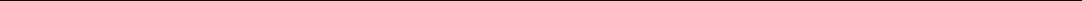
Fig. 5 Analysis of Whi7 function in transcription at Start. a Cultures of cdc15 SIC1-myc whi7 (JCY1843) transformed with the pWHI7 or pWHI7-NP centromeric plasmid were arrested in telophase by incubation for 3 h at 37 °C ( > 95% of cells arrested). After the release from the arrest, Whi7 binding to CLN2 and RNR1 promoter was investigated by ChIP assays. Western blot shows Whi7, Sic1, and Cdc28 (as loading control). Cell cycle progression was monitored by the oscillations of Sic1 and bud emergence that indicated execution of Start at 60 min. b Cultures of GAL1:CLN3 cln1 cln2 WHI7-GFP (JCY2008) were arrested in G1 by incubation for 3 h in YPD medium. Then, cells were transferred to YPGal medium and Whi7 binding to CLN2 promoter was investigated by ChIP assays. Western blot shows Whi7 and Cdc28. Cell cycle progression was monitored by bud emergence that indicated execution of Start at 45 min. c The level of CLN2 mRNA relative to ACT1 mRNA as a control was analyzed by quantitative RT-PCR in cells transformed with the pWHI7 plasmid. d β -galactosidase activity in extracts from wild type (W303), cln3 (MT244), and cln3 whi7 (JCY1868) strains ( left ) as well as from wild- type cells containing a control vector or the pGAL1:WHI7 plasmid ( right ), transformed with the pSCB:lacZ reporter gene. e Whi7 binding to CLN2 and RNR1 promoter was investigated by ChIP assays in asynchronous cultures of wild type (W303), swi4 (JCY167), and mbp1 (JCY624) and in α -factor arrested cultures of wild type (W303), swi4 (JCY167), and swi6 (JCY325) strains transformed with the pWHI7 plasmid or a control vector (no tag). f Cells expressing a myc-tagged Swi4 (JCY1879) or myc-tagged Swi6 (JCY622) proteins at endogenous level were transformed with the pWHI7 plasmid or a control vector. Whi7 was immunoprecipitated from crude extracts and the presence of Whi7, Swi4-myc, and Swi6-myc in the input, unbound, and immunoprecipitated fractions was determined by western analysis. The same experiment was carried out with cells expressing a HA-tagged Whi5